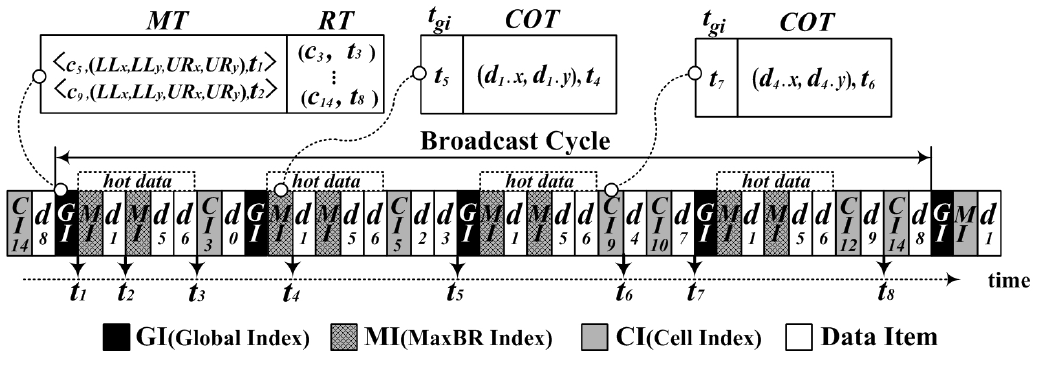
Figure 4. The wireless channel structure with